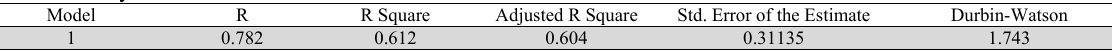
Model Summary Model